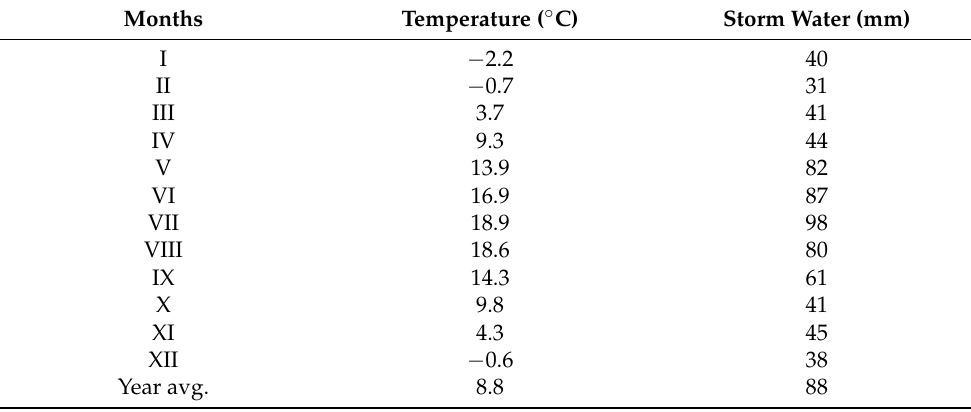
Table 1. Distribution of average temperatures and